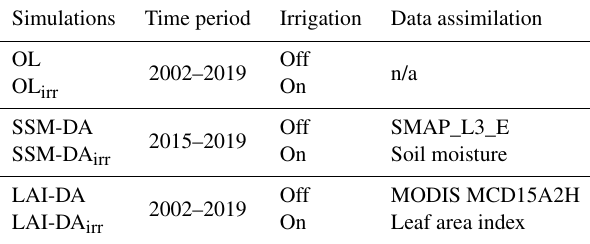
Table 2. Summary of the